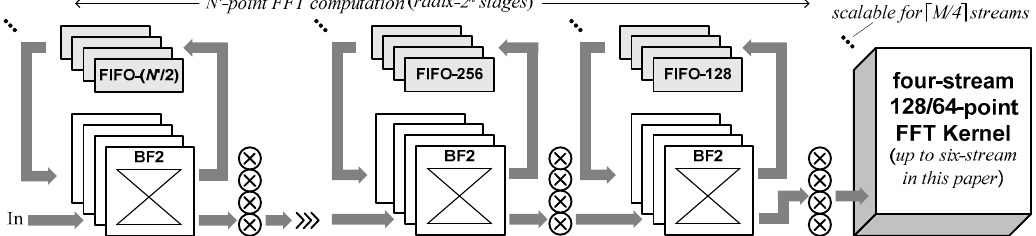
Figure 5. Block diagram showing the hardware architecture of M-stream N-point FFT processor using a. four-stream 128-point FFT kernel.